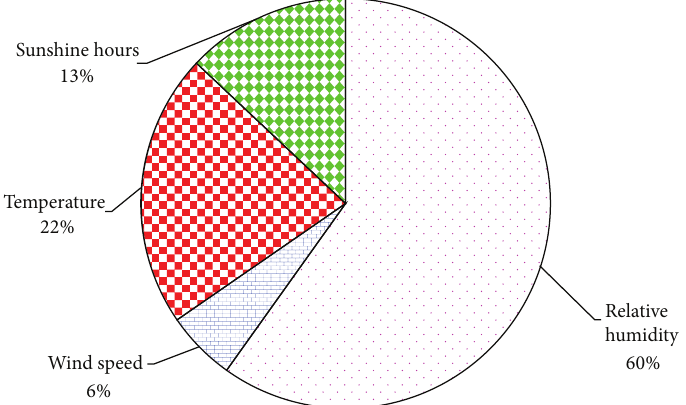
Figure 11: The contribution of each climatic variable change to ET 0 variation.